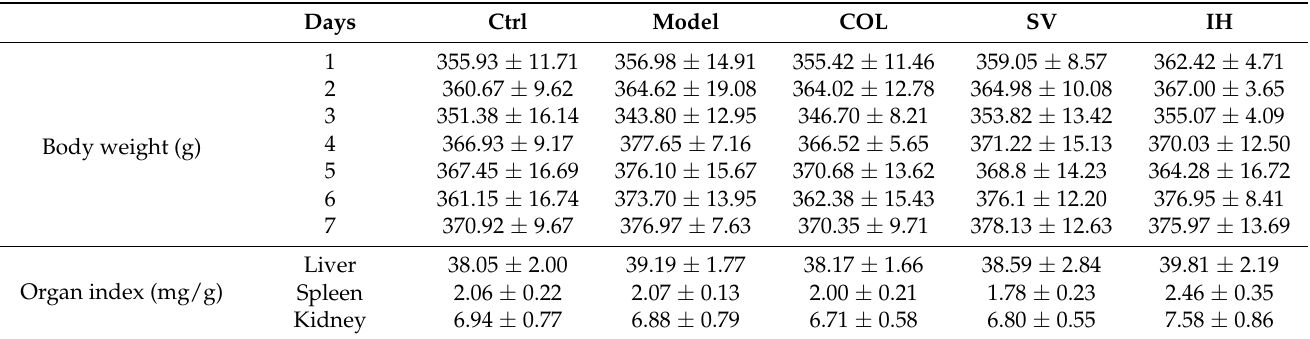
Figure 4. Histopathological assessment of the liver ( A ), spleen ( B ), kidney ( C ), and ankle articular cavity ( D ) in rats with acute gouty arthritis via H&E staining observed with light microscopy ( n = 3) (100×). Scale bar, 200 μ m. Table 2. Effects of SV and IH on body weight and indices of the liver, spleen, and kidney in rats with gouty arthritis.